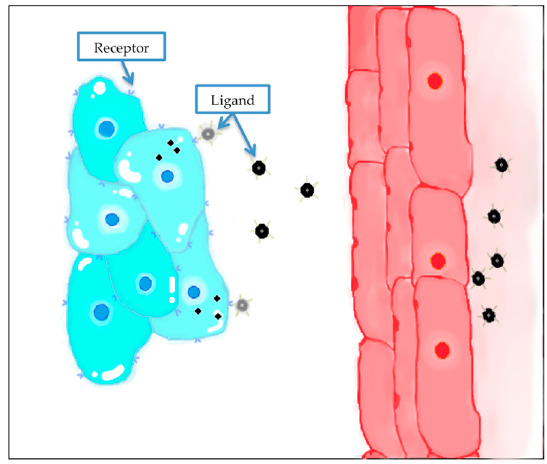
Figure 4. Schematic of the active targeting process: NPs have been functionalized by adding ligands onto their surface that can recognize and bind the receptors in cancer cells.